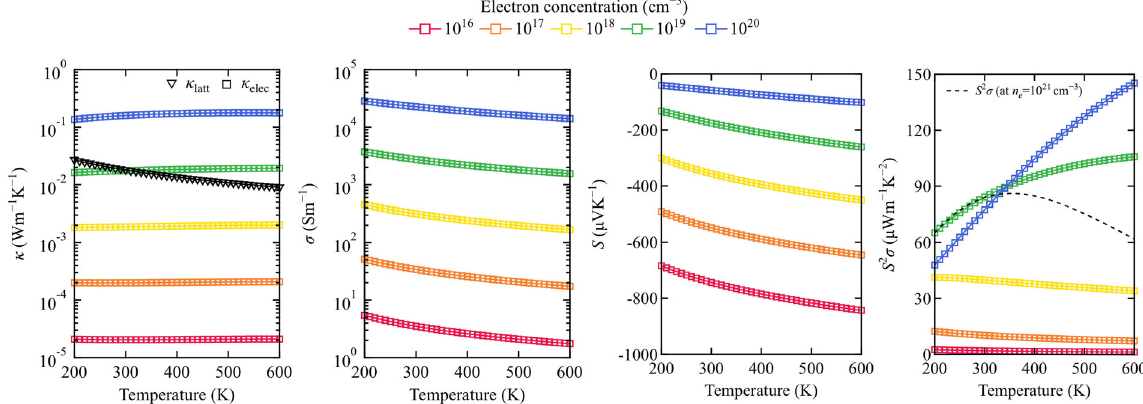
Fig. 3 Transport property analysis. Electronic transport properties of Cs 3 Cu 2 I 5 as a function of temperature and carrier concentration. κ σ stands for the electrical κ stands for the thermal conductivity, where κ latt is contribution of phonons and elec is contribution of electrons. conductivity, S stands for the Seebeck coef fi cient, and S 2 σ denotes the power factor.